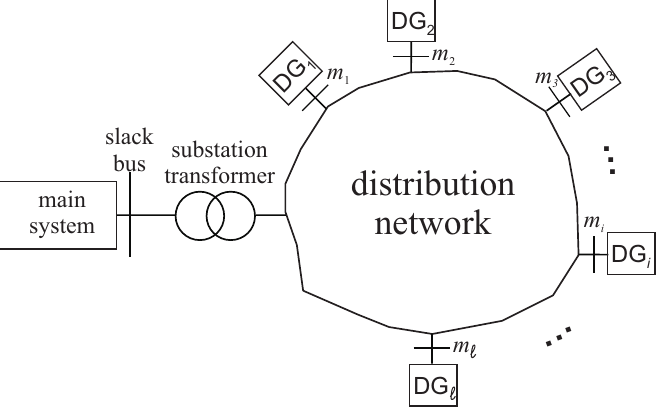
Figure 1. Distribution system with